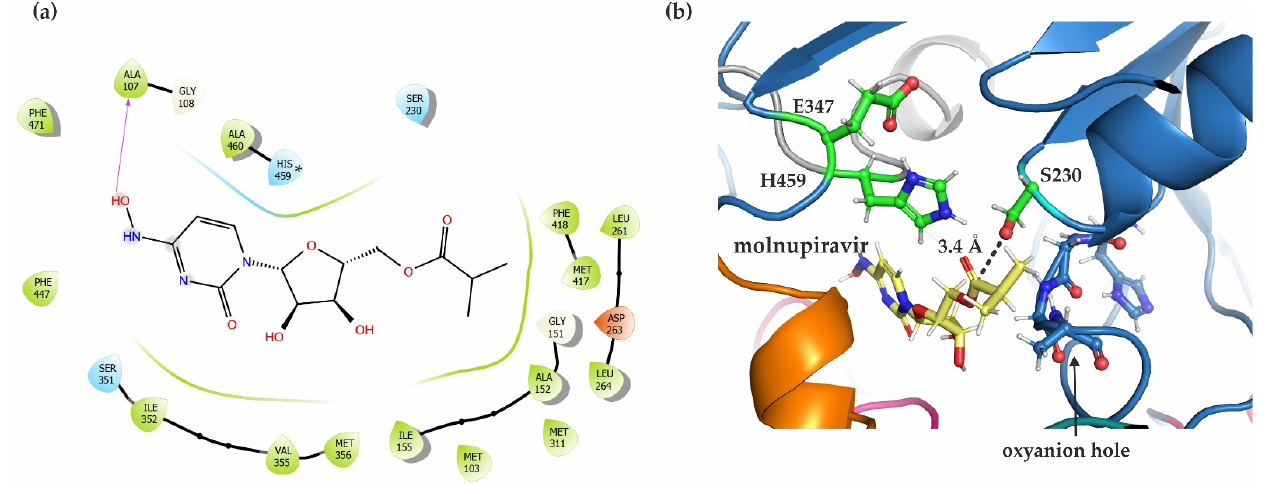
Figure 6. Molecular docking of the prodrug molnupiravir into mCes2c. ( a ) The ligand interaction diagram shows mCes2c residues within a 3.5 Å radius of molnupiravir. Pink arrow denotes H- bonding interaction. The asterisk * is placed to indicate that H459 is in the doubly protonated state. ( b ) 3D image displaying the proximity of active site residues to the ligand. The distance from carbonyl carbon of molnupiravir and the oxygen of S230 is 3.4 Å. The catalytic triad and oxyanion hole residues are depicted as green and blue sticks, respectively.